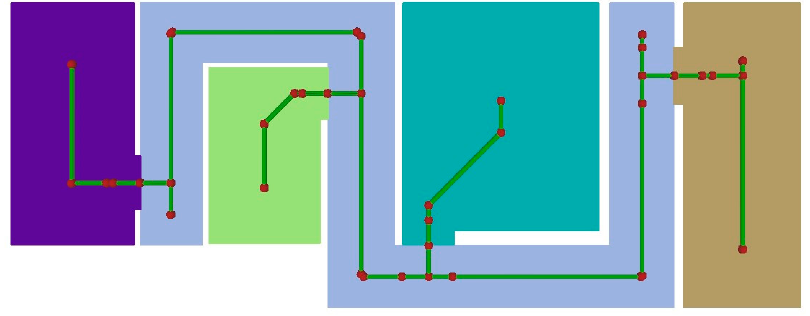
Figure 6. The result of the third proposed method.